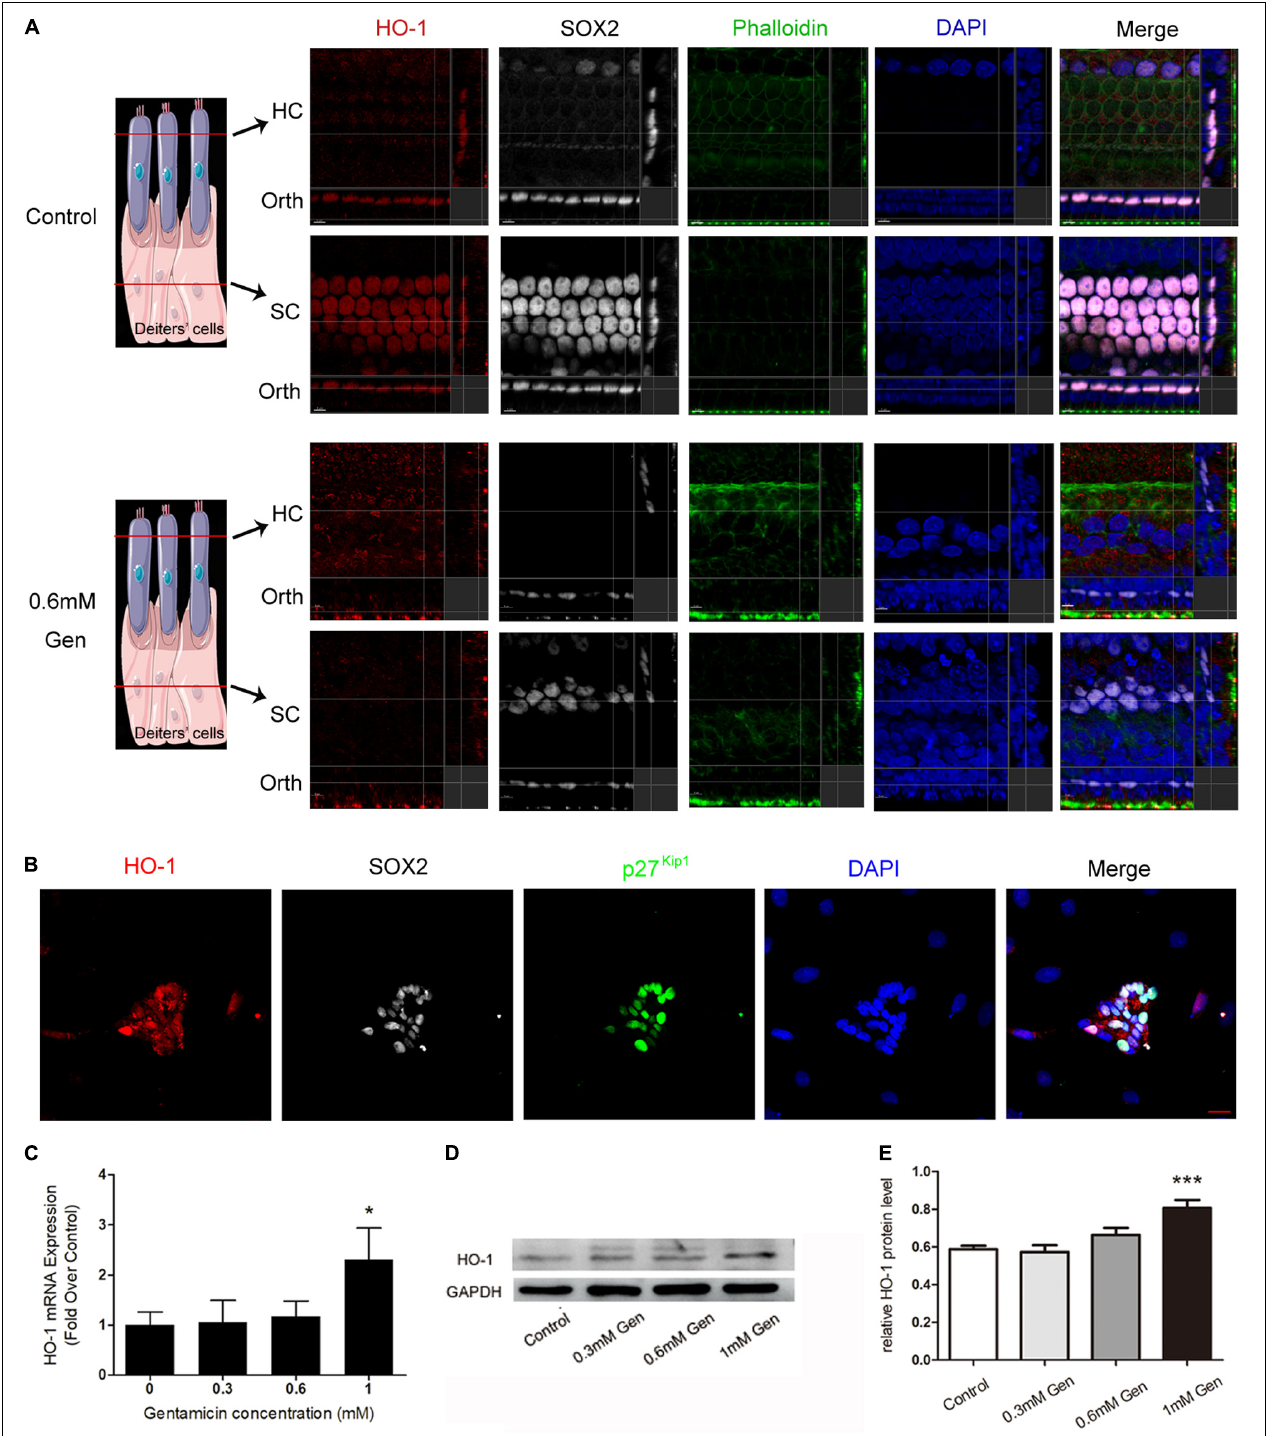
FIGURE 3 | Verification of heme oxygenase-1 (HO-1) expression. (A) The localization of HO-1 (red), phalloidin (green), SOX2 (white), and DAPI (blue) before and after gentamicin (0.6 mM) treatment. The schematic showed the location of each panel. The upper panels show confocal images taken at the level of the hair cell cuticular plates; the lower panels show confocal images from the same field taken at the level of the supporting cell plates. Scale bar = 7 µ m. Orth, orthogonal. (B) Micrographs depicting immunostaining for HO-1 in SCs without gentamicin in vitro . Scale bar = 20 µ m. (C) The mRNA levels of HO-1 in the organs of Corti cultured separately in media containing different concentrations of gentamicin (* P < 0.05, n = 3). (D) Immunoblot detection of HO-1 in the organs of Corti at different gentamicin concentrations. (E) The signal of HO-1 (from D) quantitated after normalization to GAPDH and represented in bar diagrams (*** P < 0.001, n = 3).